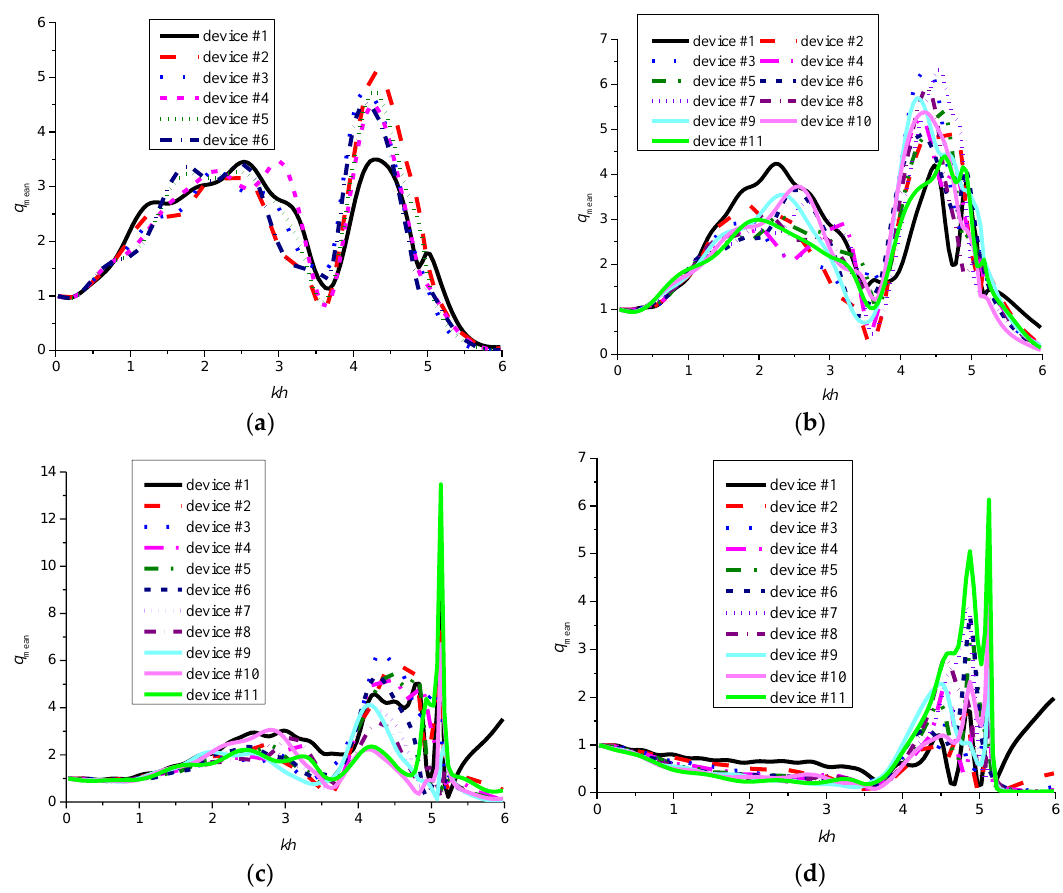
Figure 10. Individual interaction factors of all WEC devices for the WEC-pontoon system with β = 0° ( a ), 30° ( b ), 60° ( c ), and 90° ( d ).